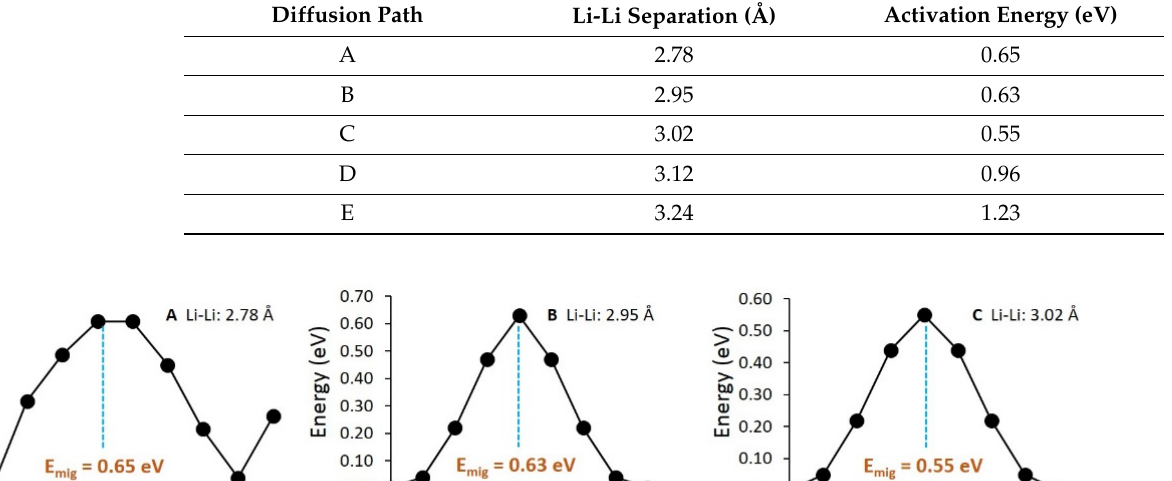
Table 4. Li hop distances and their activation energies as shown in Figure 2.